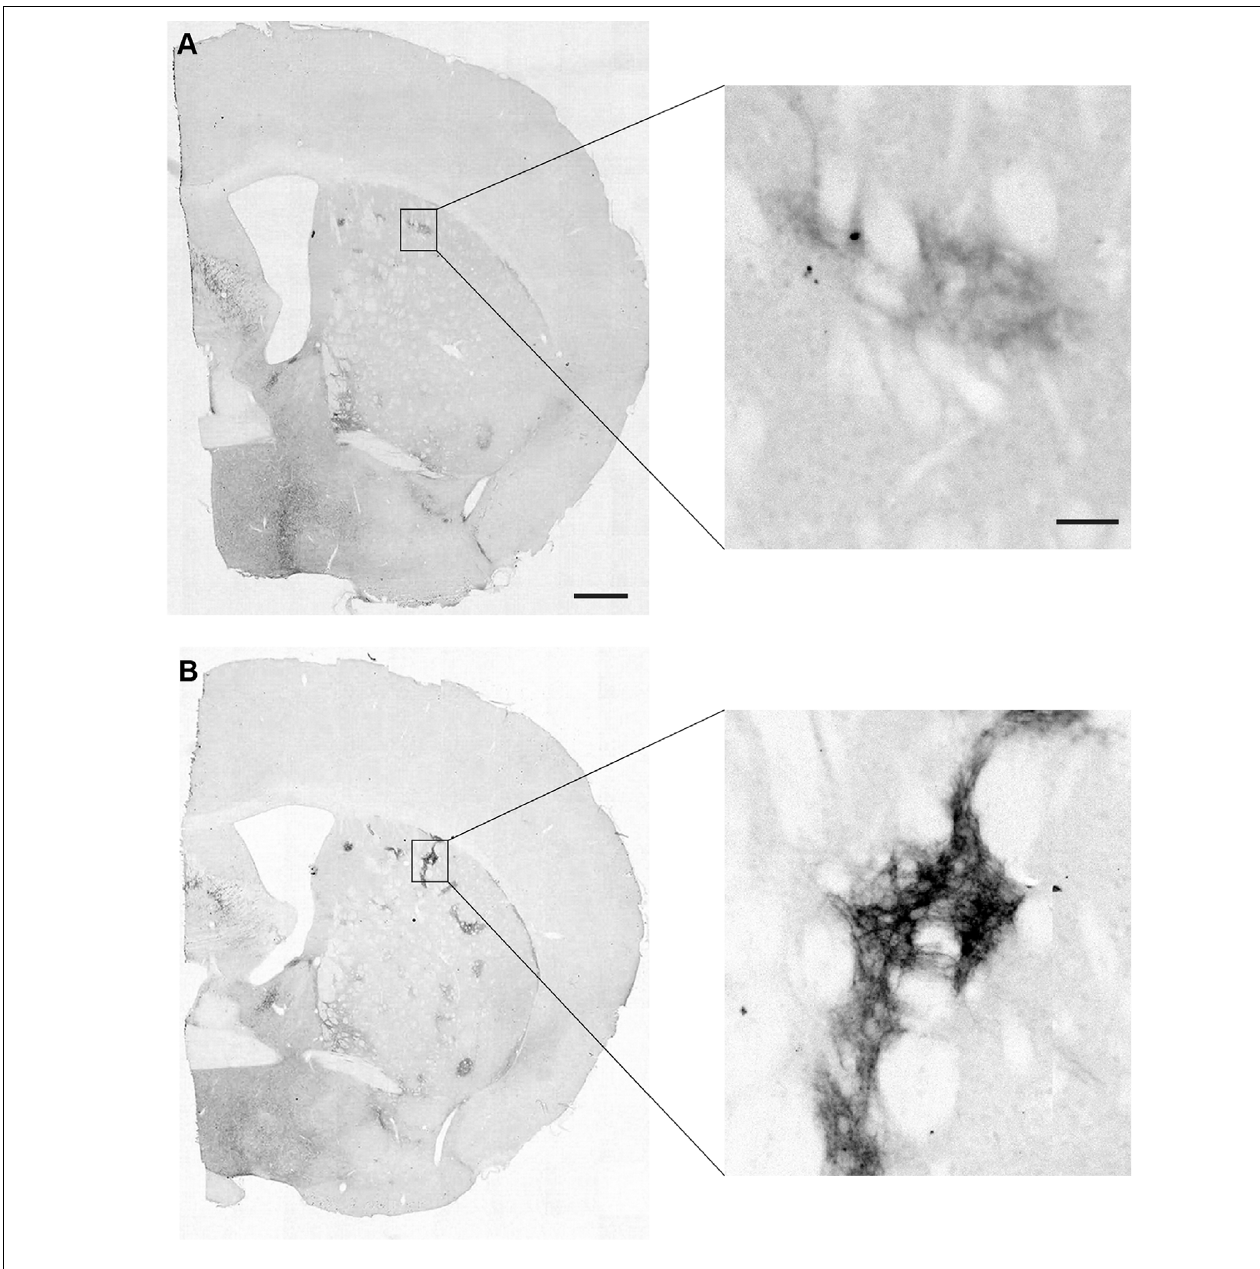
FIGURE 2 | Mu-opioid receptor 1 (MOR1) labeling in the caudal caudoputamen of wildtype (WT) and Q175KI mice at 12 months of age. Almost no MOR1-immunopositive striosomes were visible in WT mice (A) , whereas strong MOR1 immuno-labeling was detected in striosomes of the Q175KI mouse (B) . Scale bars = 500 µ m (left) and 50 µ m